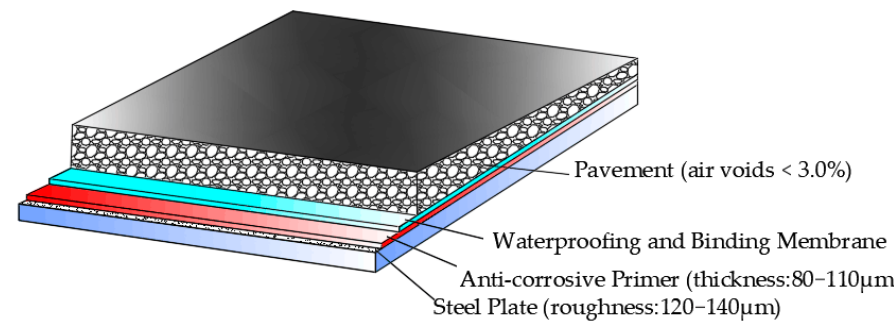
Figure 25. Optimal design of a steel deck pavement structure.